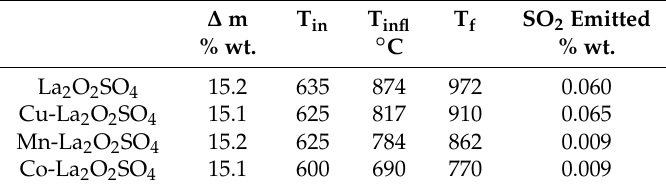
Table 2. Weight loss with onset, inflection, and final temperatures for the reduction of La 2 O 2 SO 4 and metal (Cu, Mn, Co) promoted La 2 O 2 SO 4 under a flow of 2% H 2 /N 2 ; amount of SO 2 emitted below 950 ◦ C.